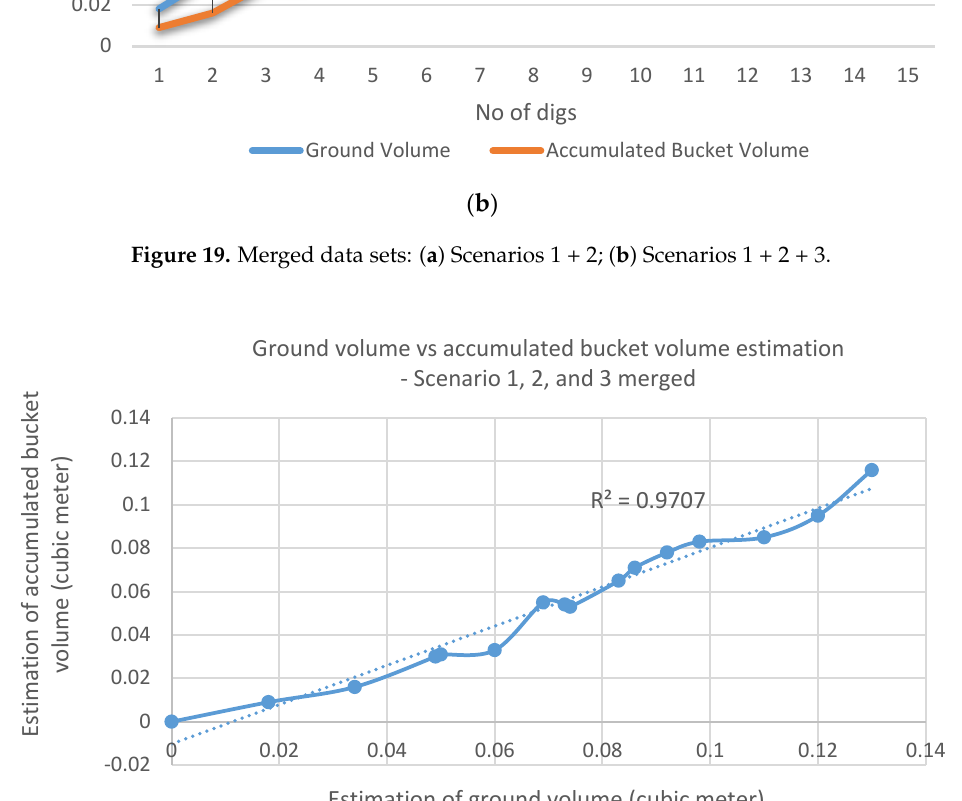
Figure 20. Relationship between the ground and accumulated bucket volume estimation. Table 2. Comparison of ground volume and accumulated bucket volume estimation.